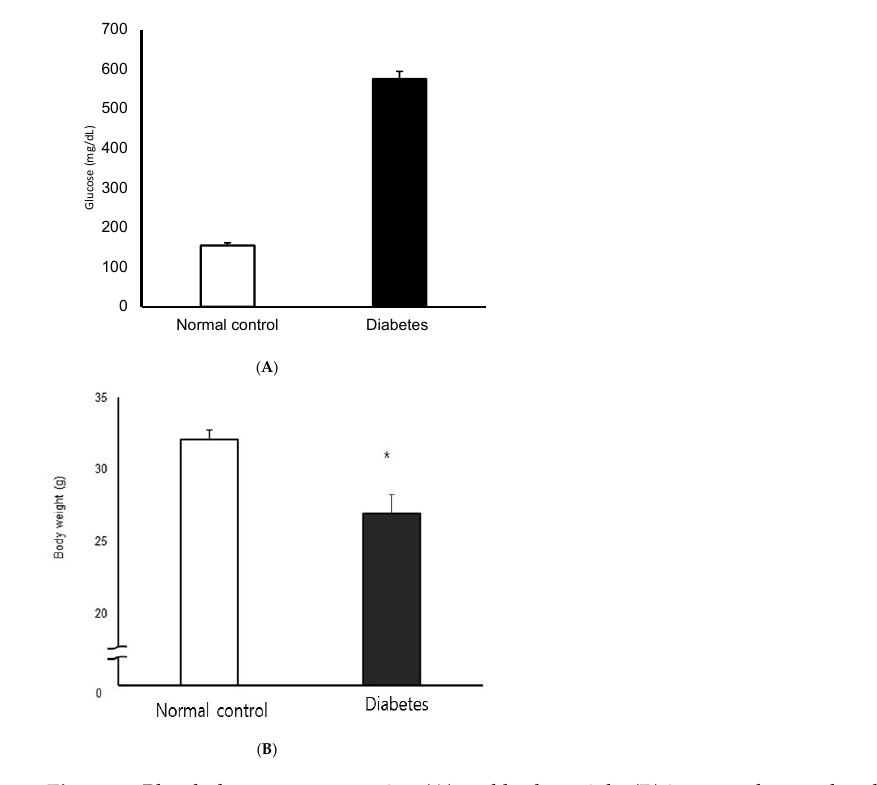
Figure 2. Blood glucose concentration ( A ) and body weight ( B ) in normal control and streptozotocin-induced diabetic mice. STZ-induced diabetic mice showed significantly higher blood glucose levels and lower body weight compared to normal control (n = 10 in each group) * p < 0.05.